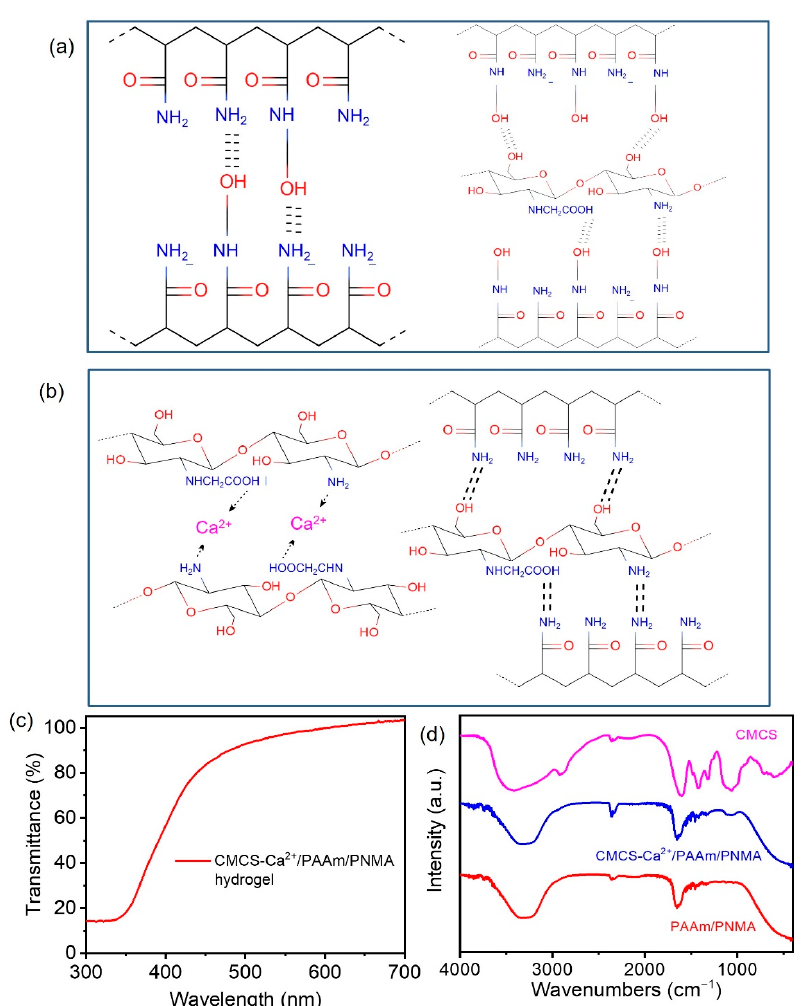
Figure 1. Illustration of the internal crosslinked networks of the as-prepared CMCS-Ca 2+ /PAAm/ PNMA hydrogels of ( a ) strong hydrogen bond crosslinking from poly(N-methylol acrylamide) (PNMA) and ( b ) weak hydrogen bond and metal coordination interaction between carboxymethyl chitosan (CMCS) and Ca 2+ ; ( c ) ultraviolet–visible (UV–vis) transmittance spectra of the as-prepared CMCS-Ca 2+ /PAAm/PNMA hydrogels; ( d ) Fourier transform infrared spectoscopy (FT-IR) spectra of CMCS, PAAm/PNMA and CMCS-Ca 2+ /PAAm/PNMA